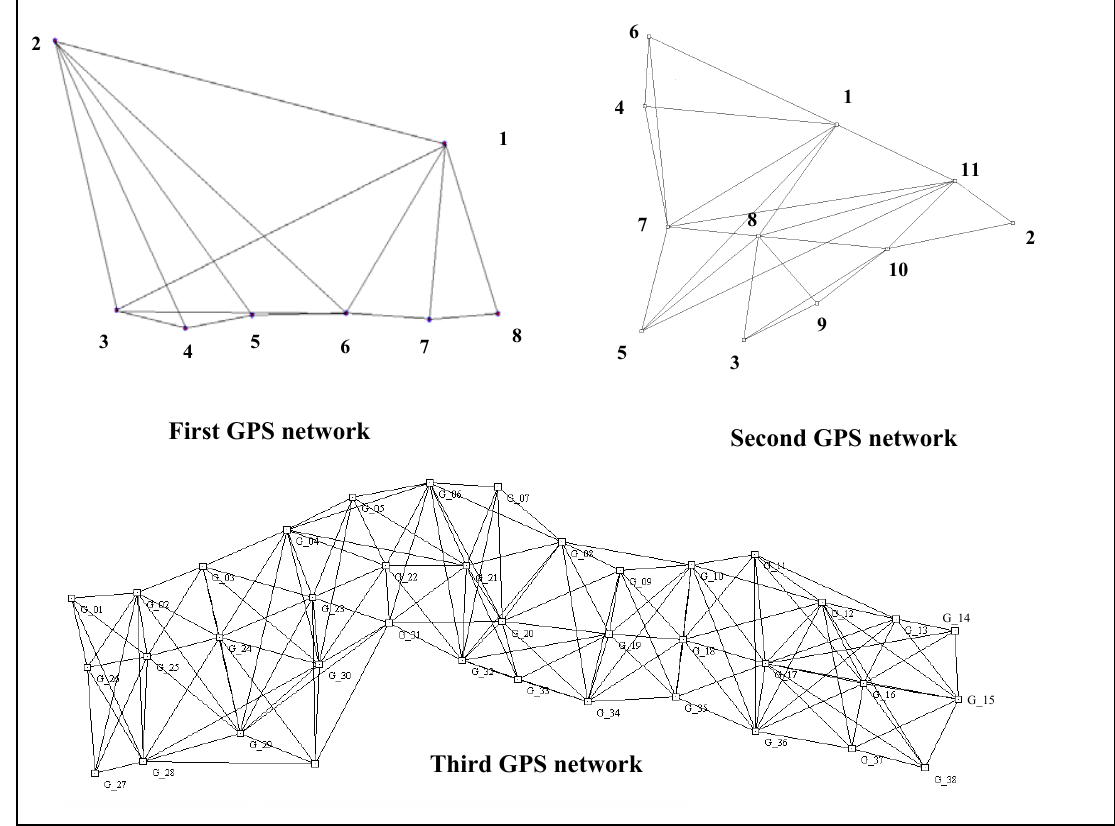
Figure 1. First, second and third GPS